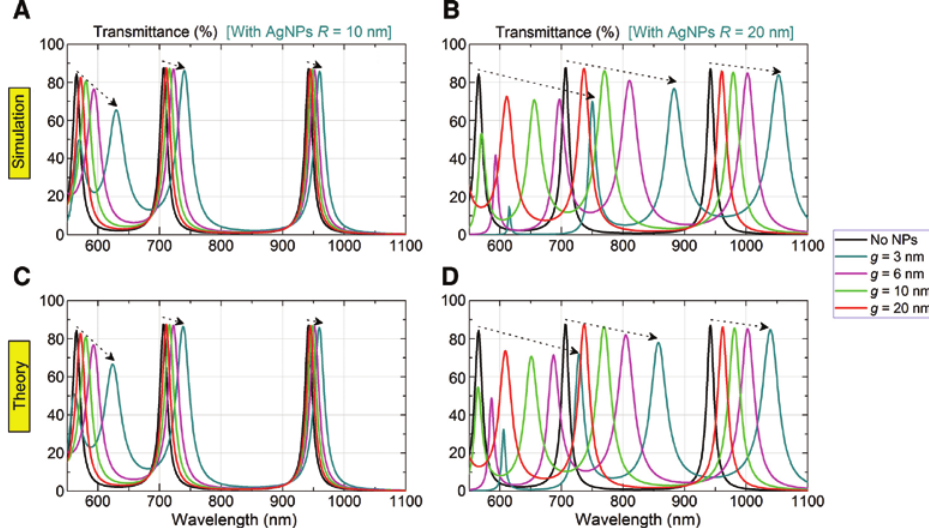
Figure 4: Tunability of transmittance